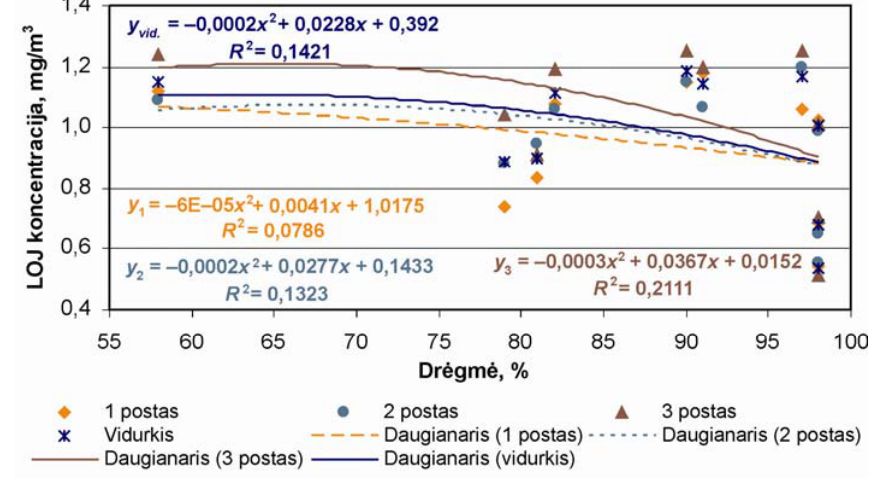
Fig 8. Dependence of VOC concentration in ambient air on wind speed (7-day results)